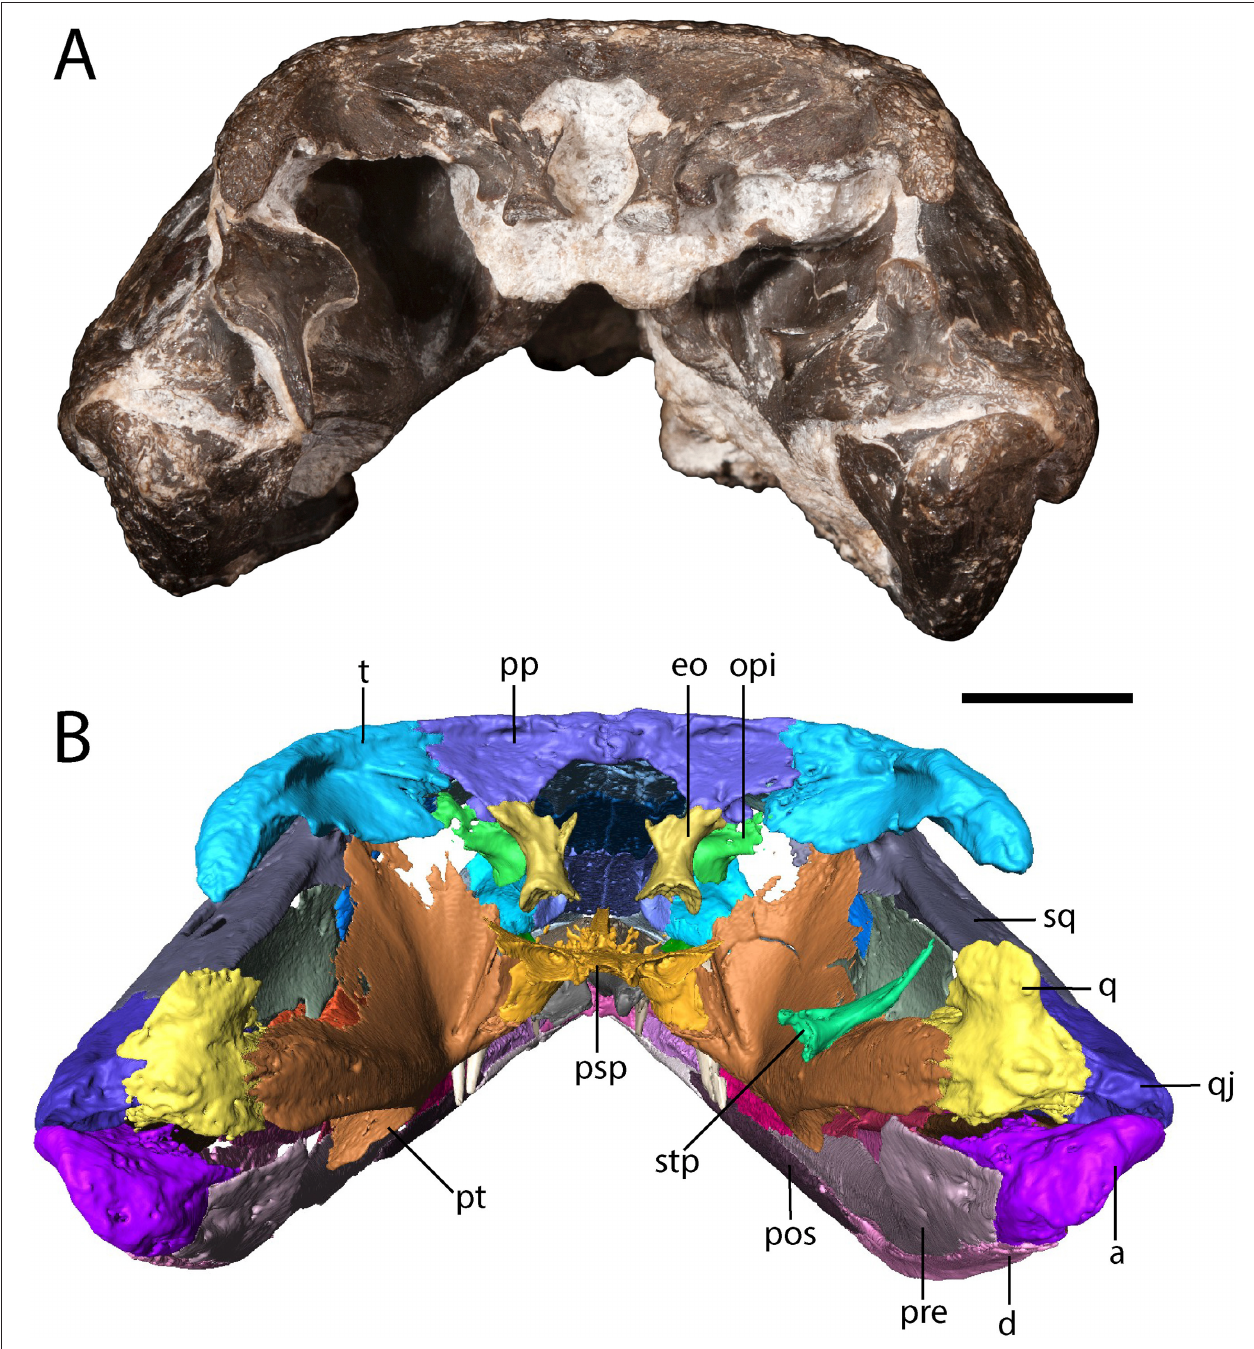
FIGURE 4 | OMNH 79318, cf. Acheloma , entire specimen in occipital profile. (A) photograph; (B) digitally segmented rendering. Scale bar equal to 1cm.